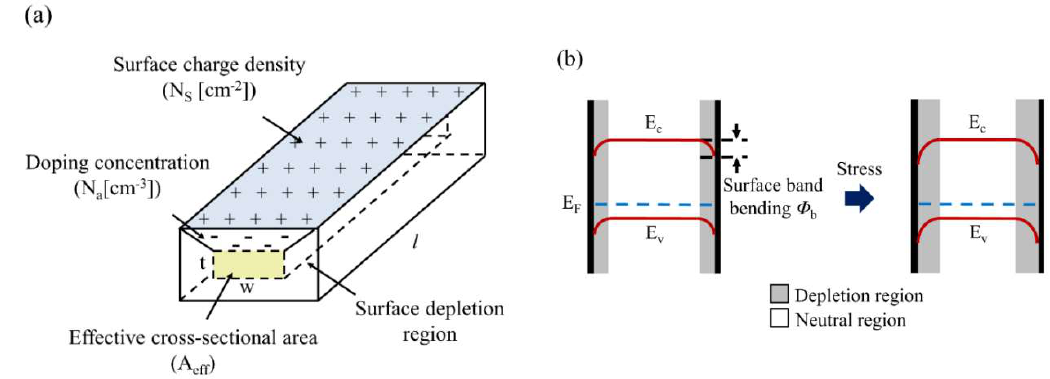
Figure 4. Conceptual schematic of the PZR model of a SiNW. ( a ) The resistance model of the fabricated SiNW; ( b ) the variation of surface depletion region when stress is applied.